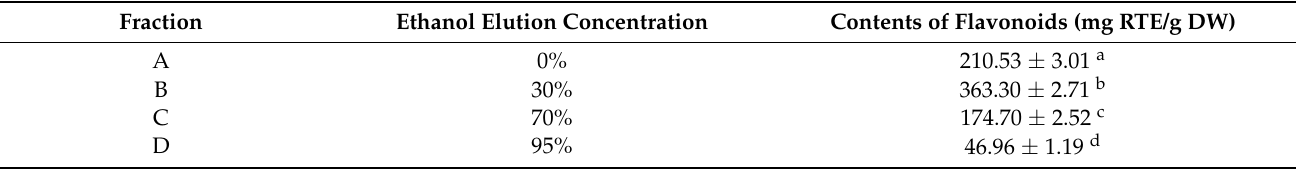
Table 4. The flavonoids contents of the eluted fraction A, B, C and